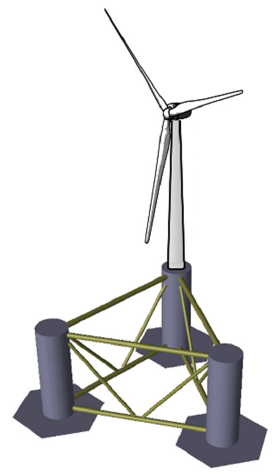
Figure 6. Schematic diagram of WindFloat SFOWT.